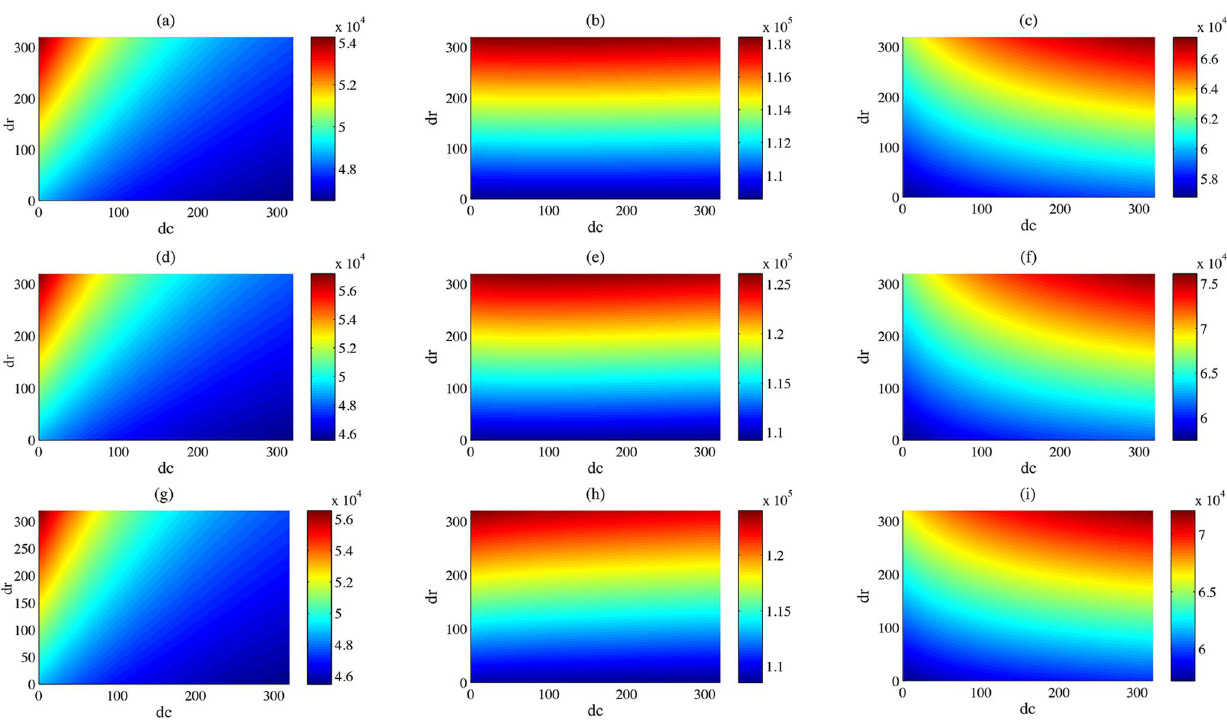
Fig. 10. Interaction between the daily increment in movement speeds and the daily imported number on the size of cumulative infected livestock population. (a)-(i), simulations of the cumulative numbers of infected livestock at year 4, 29, and 62 (by row) in patches 1, 2, and 3 (by column). Same values of parameters used in Fig. 3.